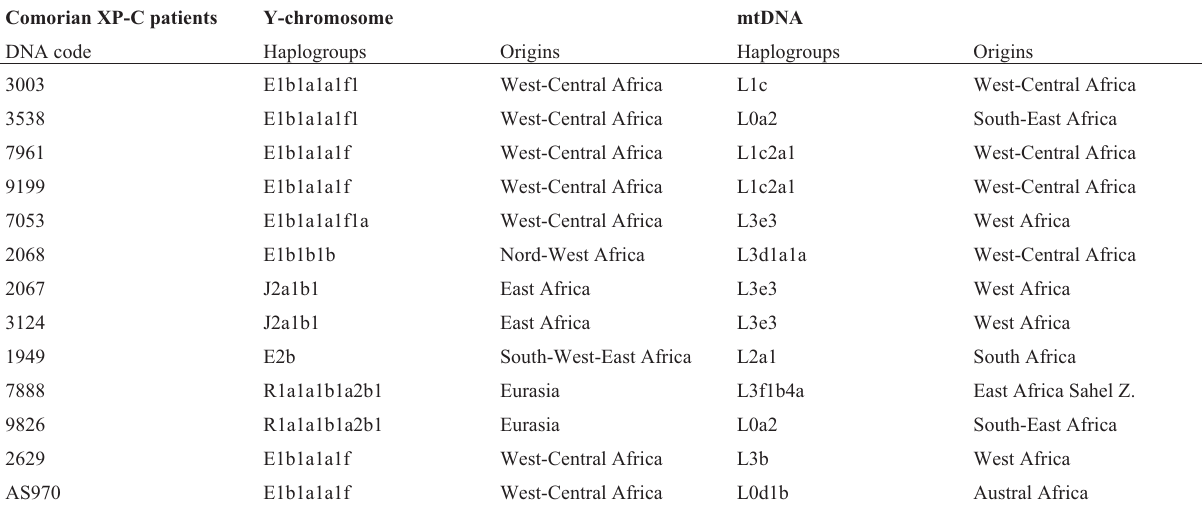
Table 1 - Geographical origins of paternal (Y-chromosome) and maternal (mtDNA) lineages of the Comorian XP-C patients reported in this study. Comorian XP-C